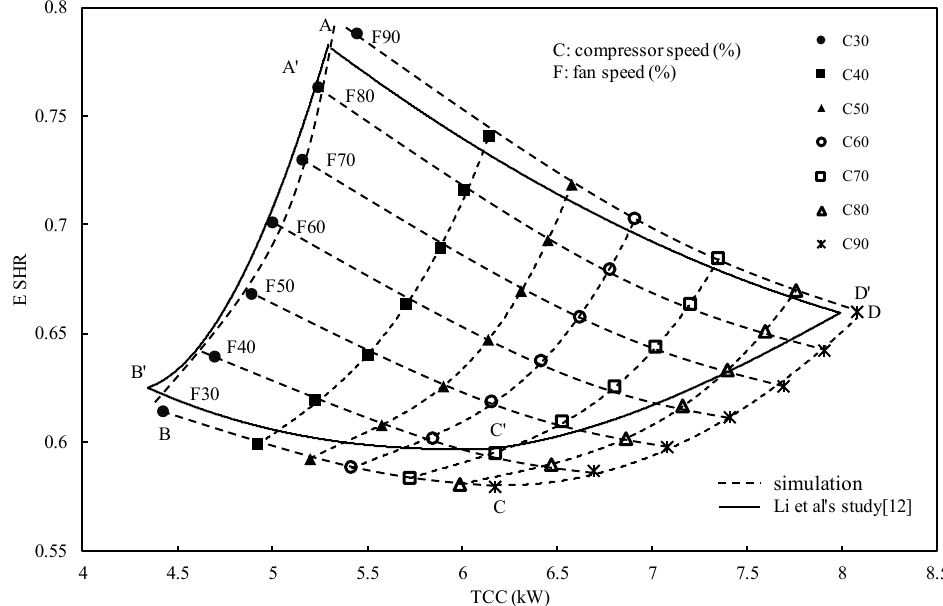
Figure 8. Inherent operating characteristics in terms of TCC and E SHR under variable speed operation.